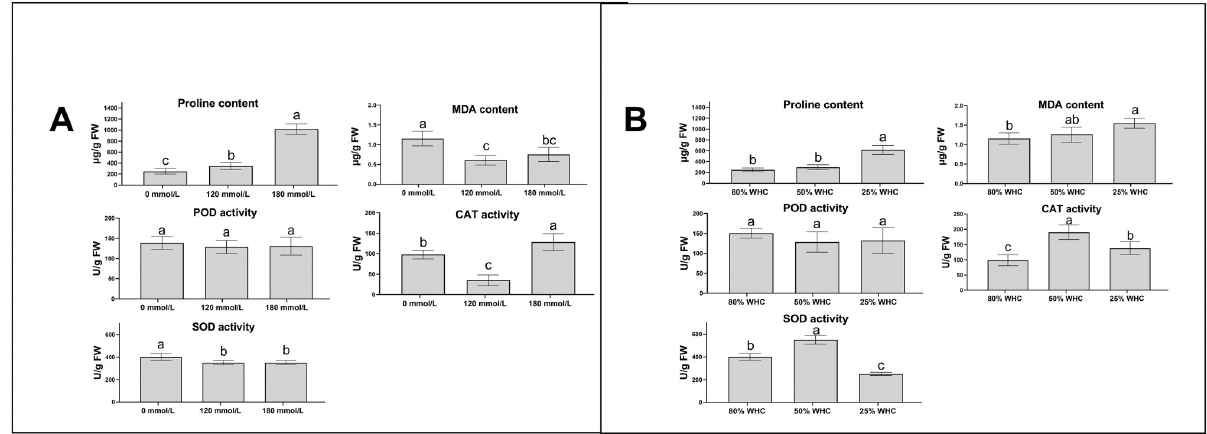
Fig 5. Physiological responses of C . humilis ’ leaves to salinity (A) and drought (B) stresses. WHC represents water holding capacity. Different lowercase letters represent significant difference (p < 0.05).